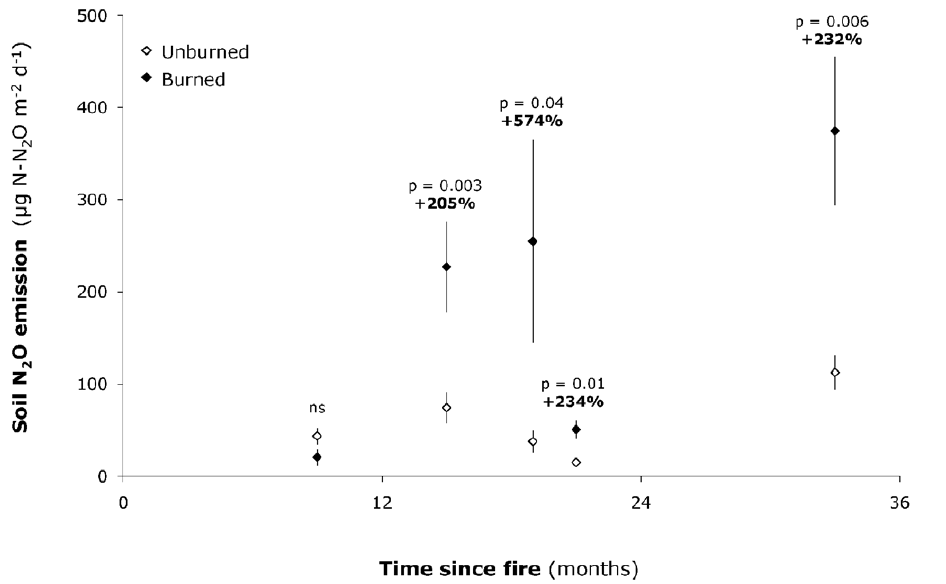
Figure 1. Soil N 2 O emission rates in the unburned and burned plots in relation to time since fire. For each measurement date (i.e. 9, 15, 19, 21 and 33 months after fire), soil N 2 O emission rates are grouped by burn treatments (unburned: open symbols, burned: closed symbols) and averaged across the CO 2 , precipitation and N treatments. Error bars denote standard error (n=48 for unburned plots; n=32 for burned plots). Results from mixed model analysis testing for a fire effect (ns: not significant) as well as relative fire effect sizes (calculated as: % effect=100 6 [burned 2 unburned]/[unburned]) are indicated.